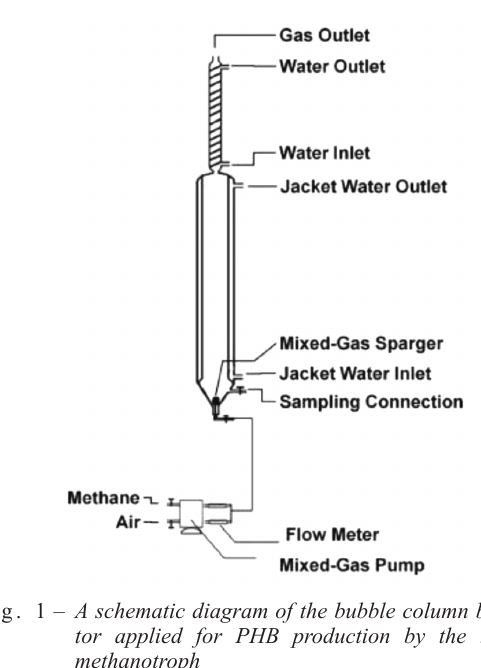
Fig. 1 – A schematic diagram of the bubble column bioreac- tor applied for PHB production by the isolated